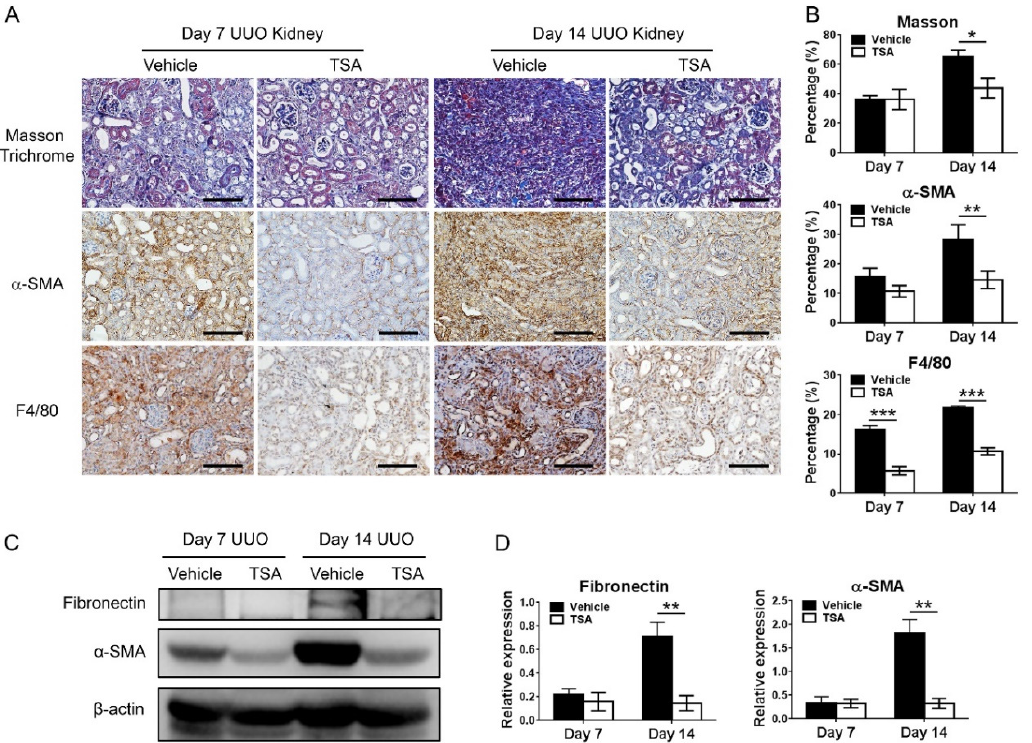
Figure 3. Trichostatin A (TSA) ameliorates renal inflammation and fibrosis in unilateral ureteral obstruction (UUO). ( A ) Representative images of Masson trichrome staining of obstructed kidneys at 7 days and 14 days following UUO in the vehicle and TSA groups. The TSA treatment markedly reduced the extent of interstitial fibrosis (blue area). Immunohistochemical staining for α -smooth muscle actin ( α -SMA, myofibroblast marker) and F4 / 80 (pan-macrophage marker) in day 7 and day 14 obstructed kidneys. Scale bar = 100 µ m. ( B ) Quantification of the fibrosis extent, α -SMA-positive and F4 / 80-positive areas. * p < 0.05, ** p < 0.01 and *** p < 0.001 by the unpaired Student’s t -test; n = 5 for each group. ( C ) Western blots of fibronectin and α -SMA in day 7 and day 14 UUO kidneys treated with the vehicle or TSA. β -actin served as the loading control. ( D ) Quantification of fibronectin and α -SMA expression levels. ** p < 0.01 by the unpaired Student’s t -test; n = 5 for each group.